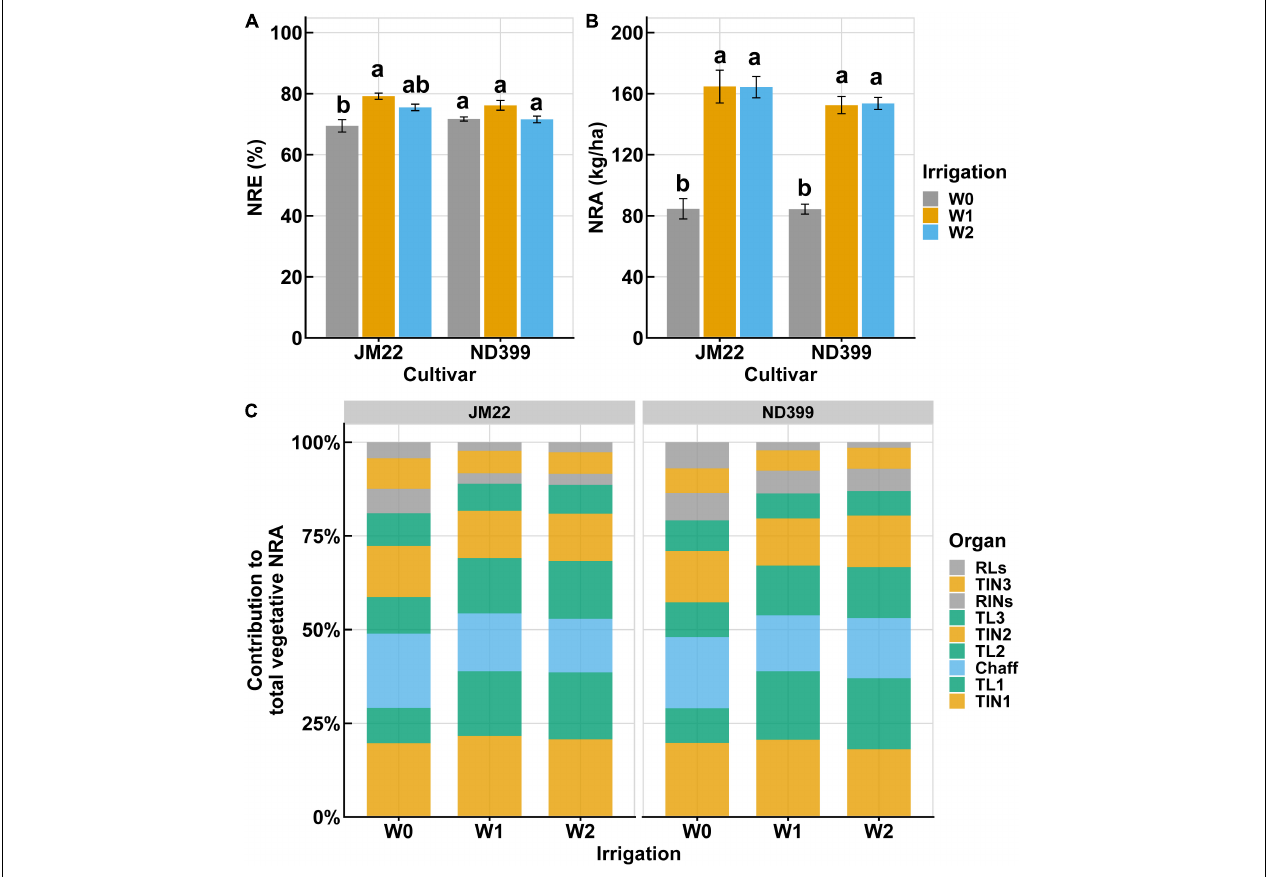
FIGURE 4 | Nitrogen remobilization varies between three irrigation treatments. (A,B) Nitrogen remobilization efficiency (NRE) and nitrogen remobilization amount (NRA) of vegetative organs in winter wheat cultivar JM22 and ND399. Irrigation treatments are shown with three different colors. (C) Contribution of separated organs to total